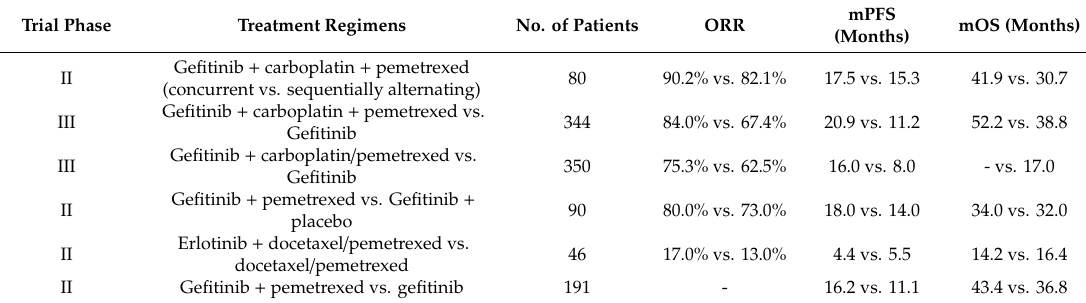
Table 3. Combination treatments of chemotherapy plus